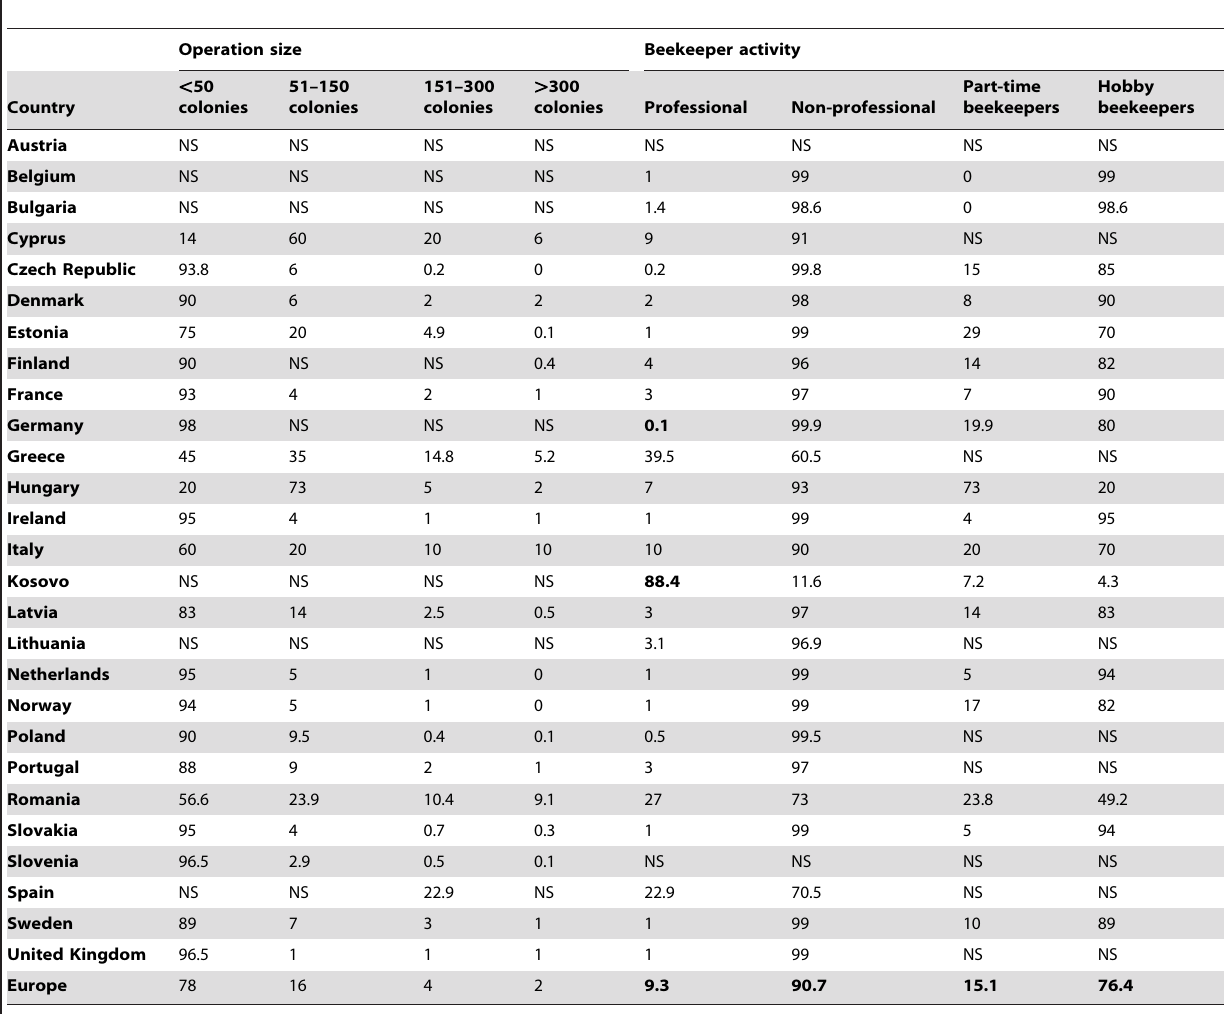
Table 2. Description of the different types of beekeeper activities and sizes of the apiaries in Europe in 2010 (percentage).